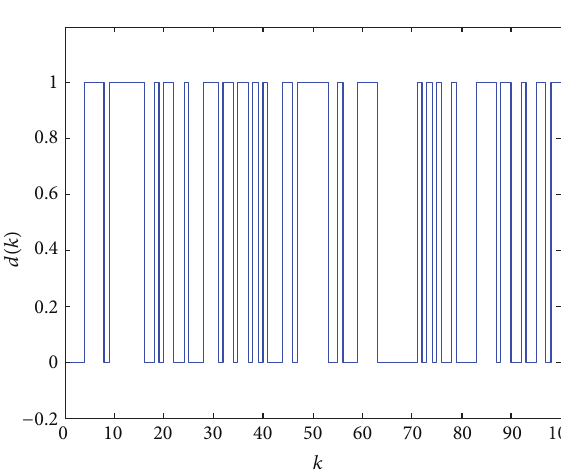
Figure 2: A simple inverted pendulum.